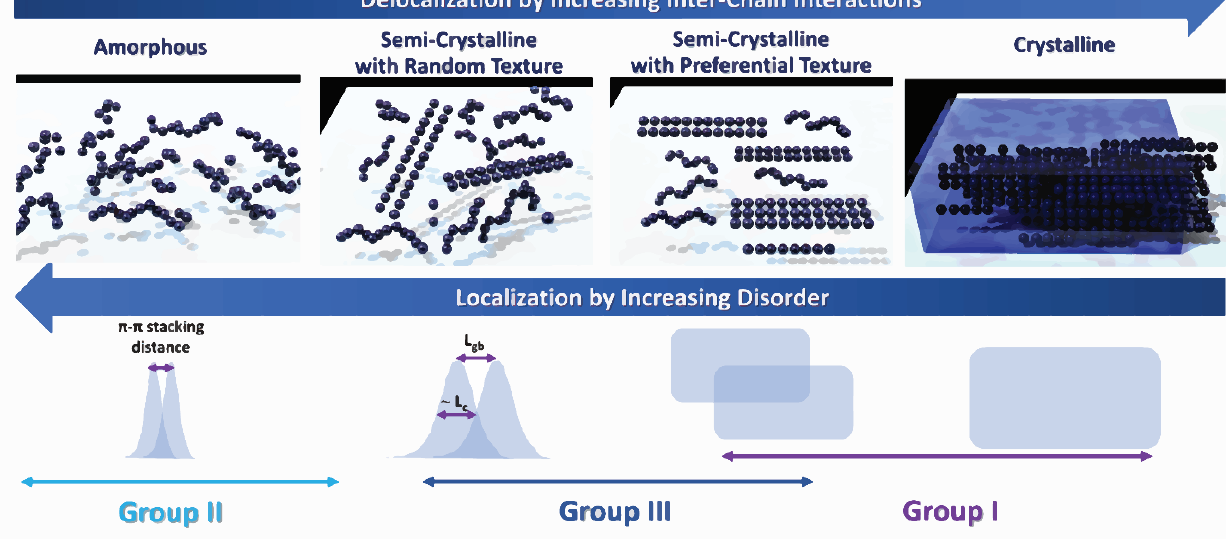
Figure 17. Schematic illustration of conjugated polymers with amorphous characteristics (semi ‐ crystalline with a random orientation, semi ‐ crystalline with a preferential texture, and single ‐ crystalline domains) [11]. Group I is related to conjugated polymers with a partial localization of extended states. Group II is related to conjugated polymers with a partial delocalization of molecular orbitals. Group III is related to conjugated polymers with a partial delocalization due to ordered domains. Reproduced with permission [11]. Copyright 2021, De